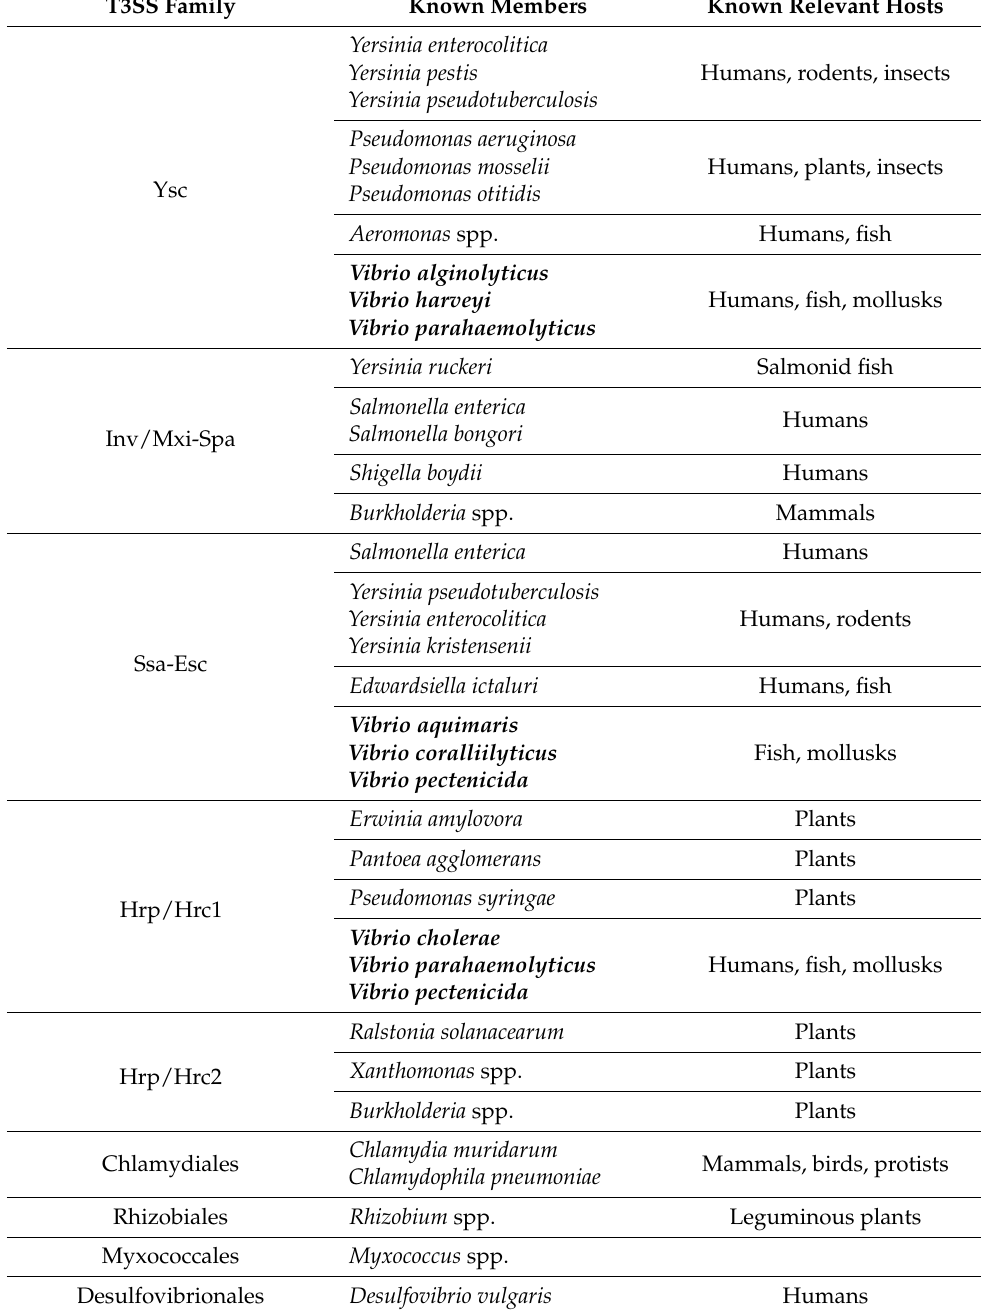
Table 1. T3SS family classification